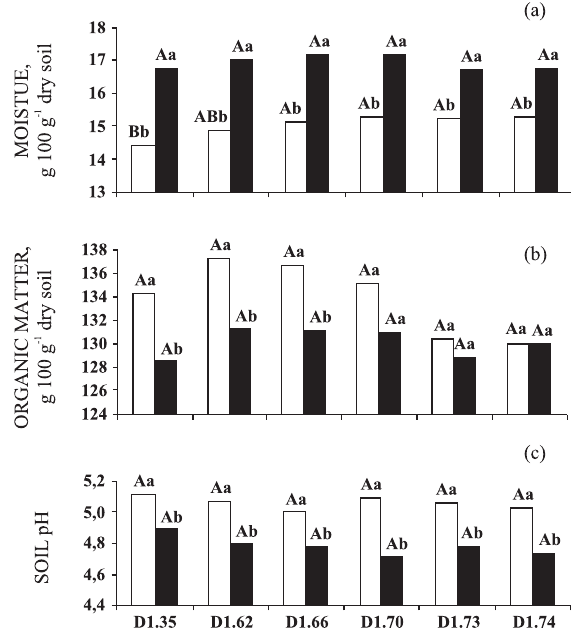
Figure 5. Moisture (a) and organic matter